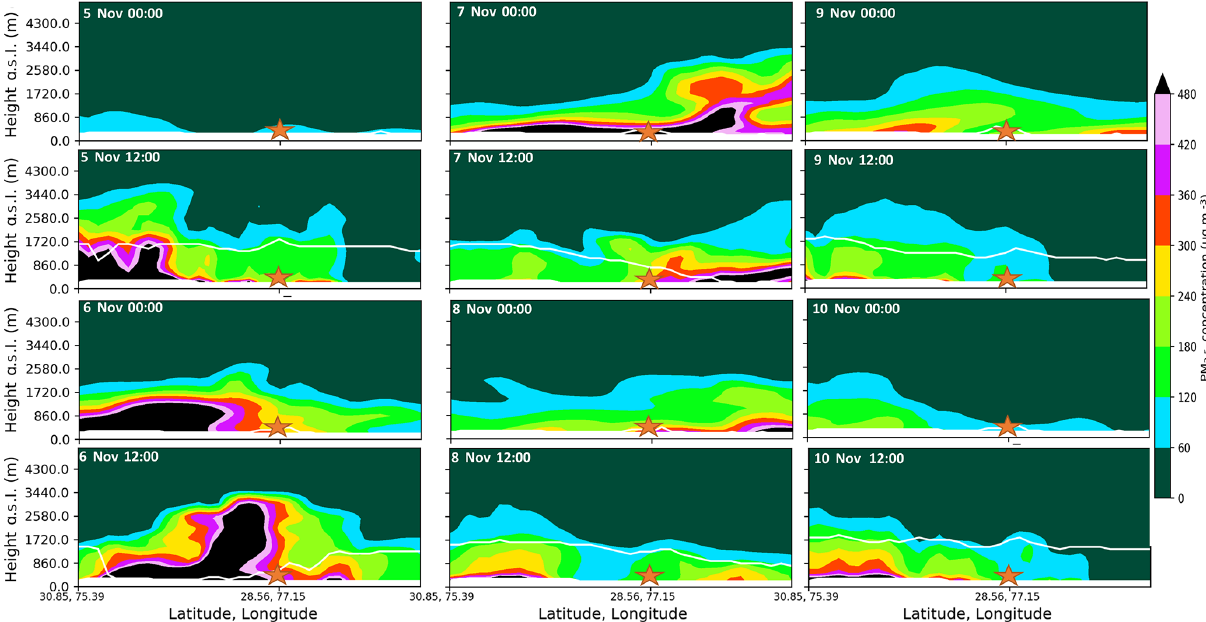
Figure 8. Vertical cross section of PM 2 . 5 concentration along the path shown in Fig. 1 for the days between 5 and 10 November. For each day, two snapshots are shown at 00:00UTC (05:30 local time) and 12:00UTC (17:30 local time). The orange star shows the location of Delhi on the path. The white line shows the PBL height across the path.